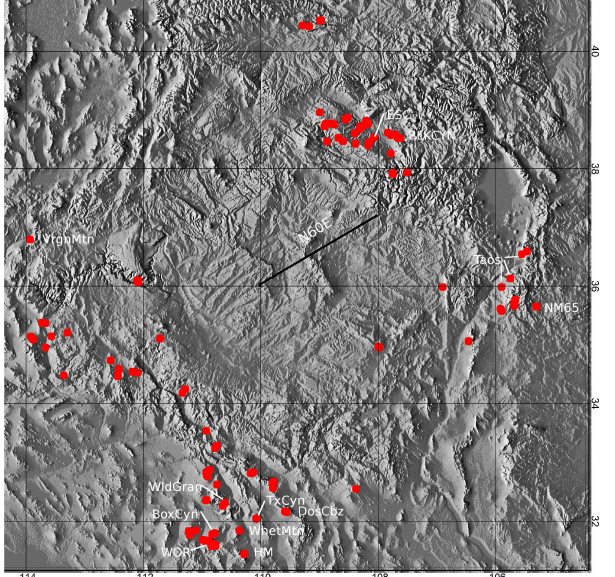
Fig. 2. Locations in the American Southwest where magnetic susceptibility measurements have been made. Labeled areas are the rock bodies discussed in this report. Horizontal axis is degrees of west longitude, and vertical axis is degrees of north latitude. Heavy black line in central part of the image shows the N60 ◦ E tectonic extension direction discussed in the text.